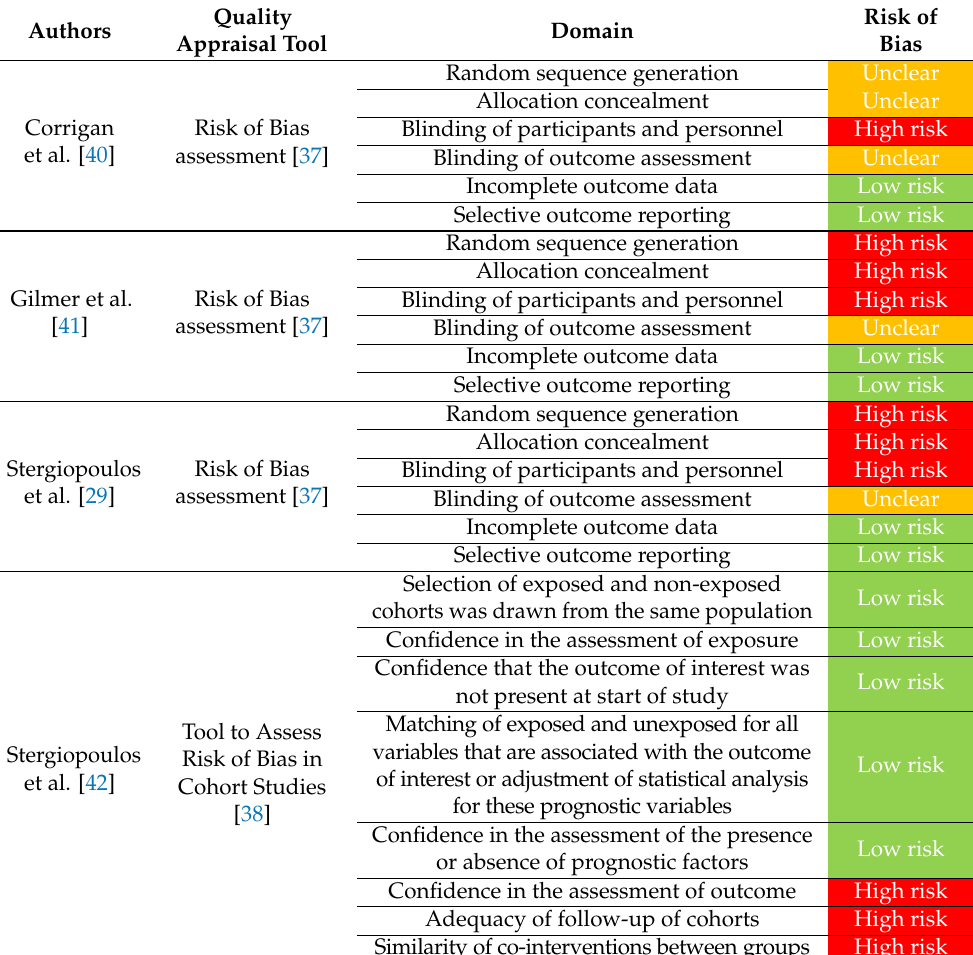
Table 2. Quality appraisal of included